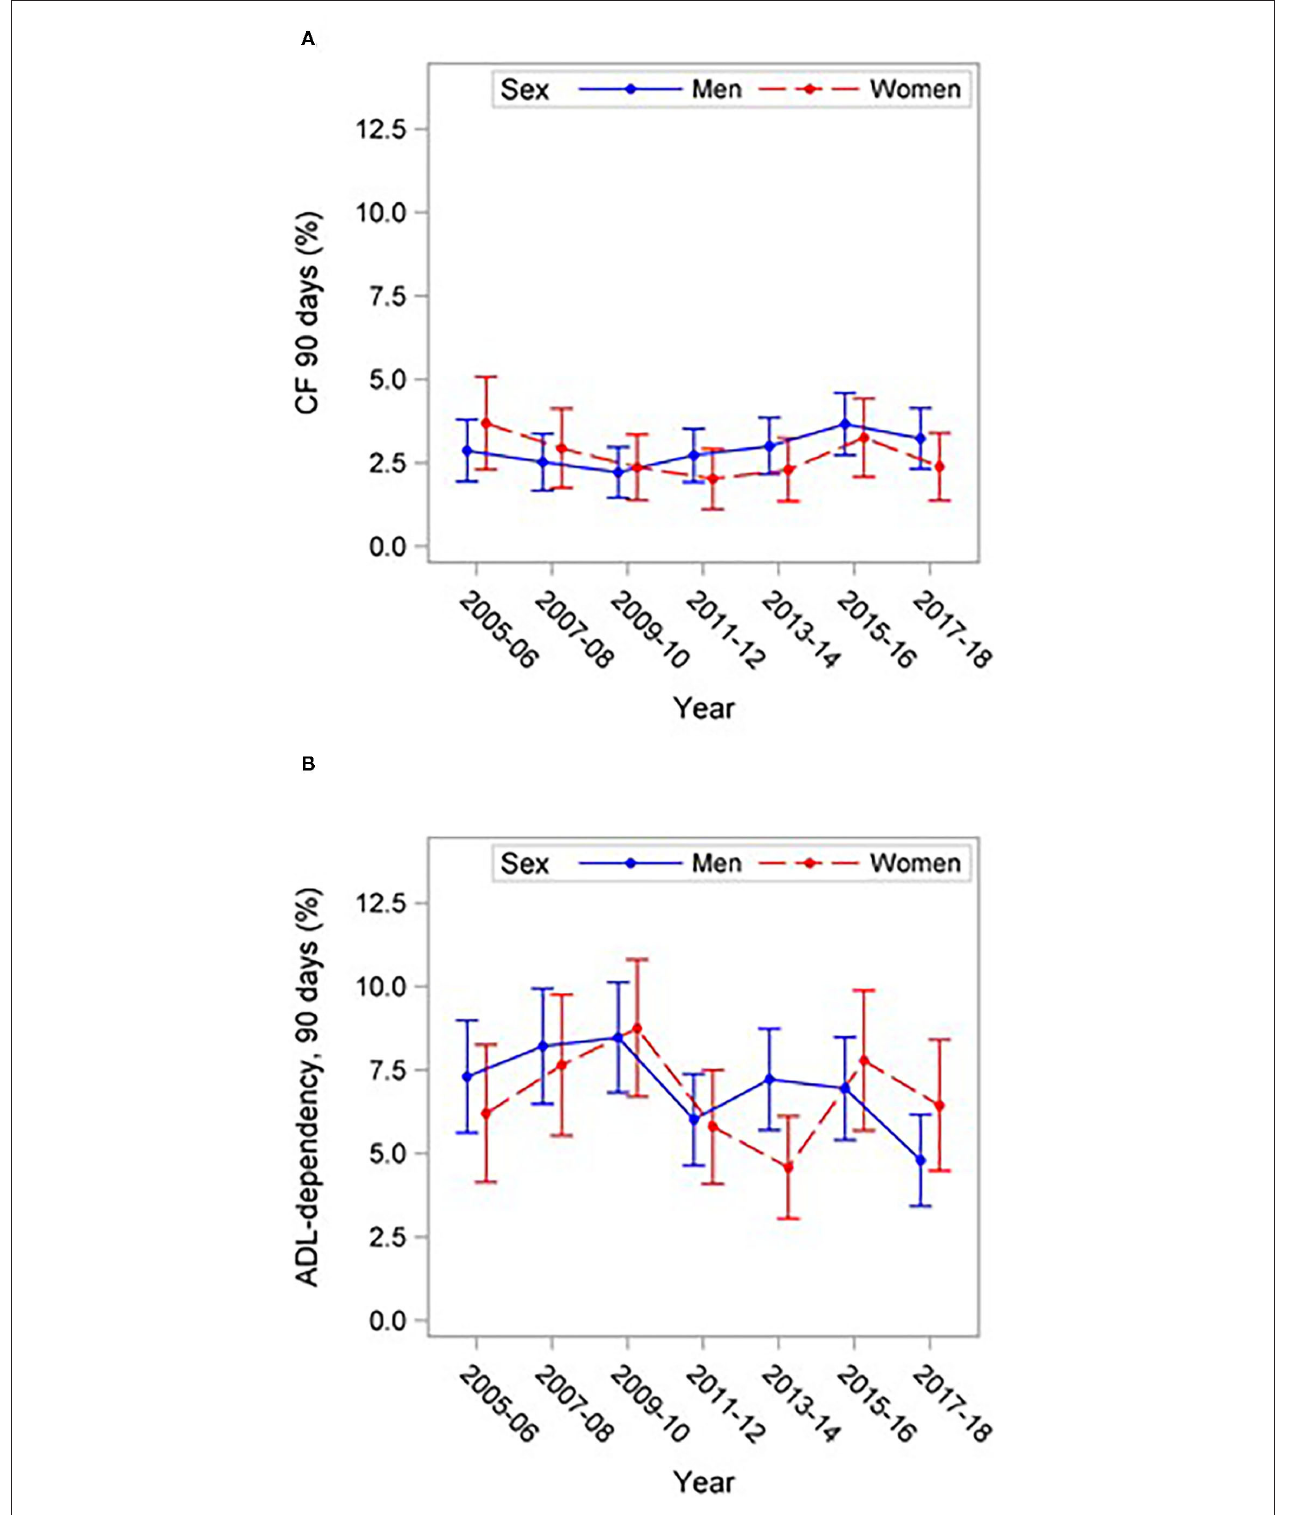
FIGURE 3 | Outcome 90 days after stroke (%) with 95% CIs in 18–54-year-old patients with stroke 2005–2018. (A) 90 days case fatality, (B) ADL-dependency in patients who were independent before the stroke.